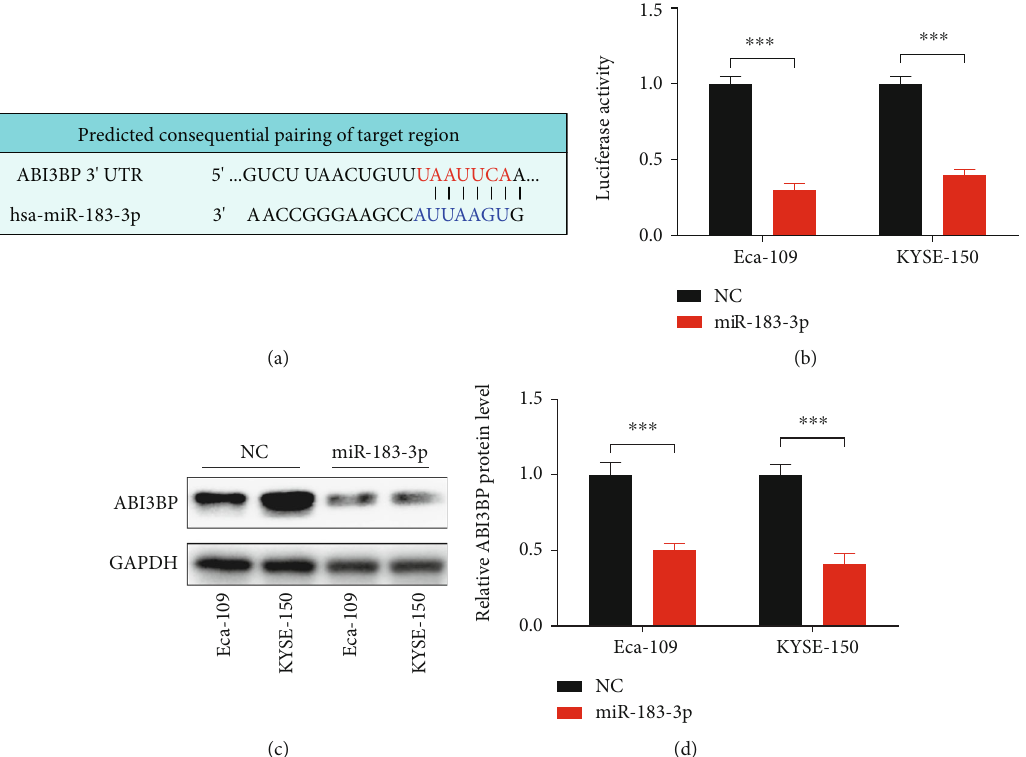
Figure 4: ABI3BP may be one of the targets of miR-183 in Eca-109 and KYSE-150 cells. (a) Predicted consequential pairing site of ABI3BP mRNA and miR-183-3p. (b) Dual-luciferase reporter assay was performed to detect the luciferase activity of ABI3BP mRNA and miR-183-3p. Three independent experiments ( n = 3 ) were repeated. (c) Two kinds of cells were cultured and harvested when growing to 80-90%. Total protein was extracted and detected by Western blot analysis. Relative ABI3BP protein level was detected by Western blot under miR-183- 3p overexpression condition. Five independent experiments ( n = 5 ) were repeated for each cell line. (d) Quantitative analysis of (c). ∗∗∗ P < 0 : 001 , Student ’ s t